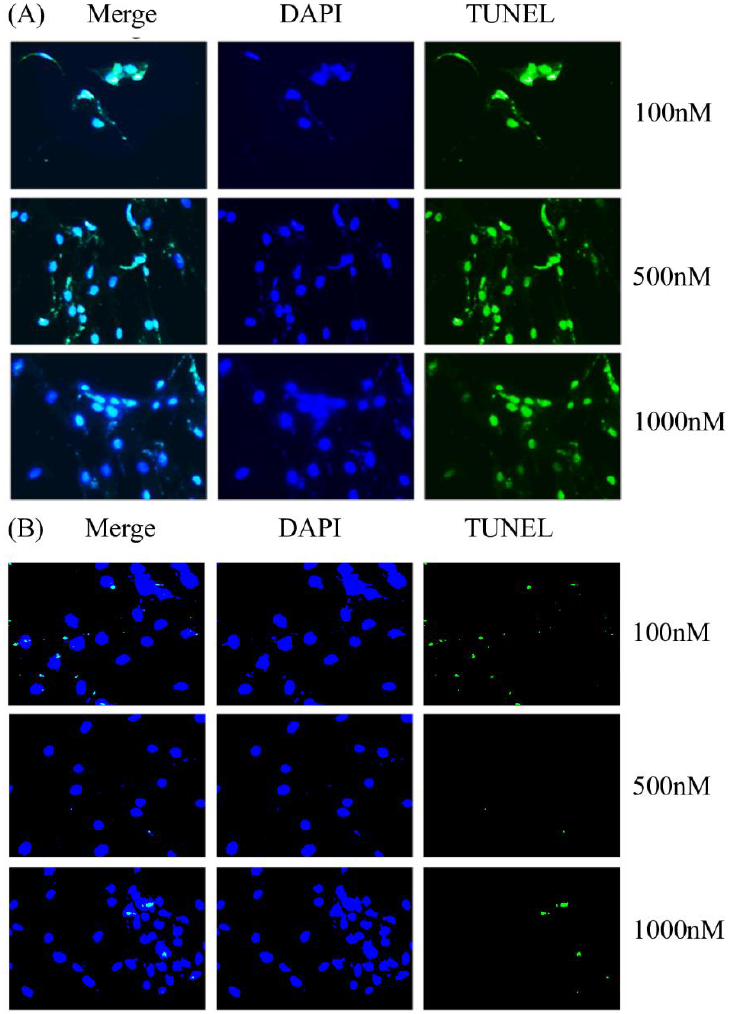
Figure 3. The representative illustration of DAPI-TUNEL staining of the BMSCs harvested from ONFH heads treated with Y1R agonist (Leu 31, Pro 34) ( A ) and antagonist BIBO3304 ( B ) of graded